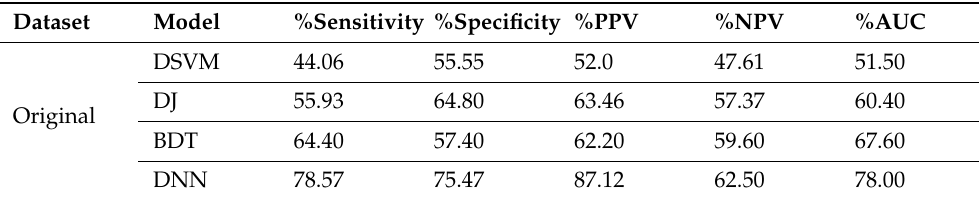
Table 3. Performance of the ML algorithms’ tests on the original dataset.